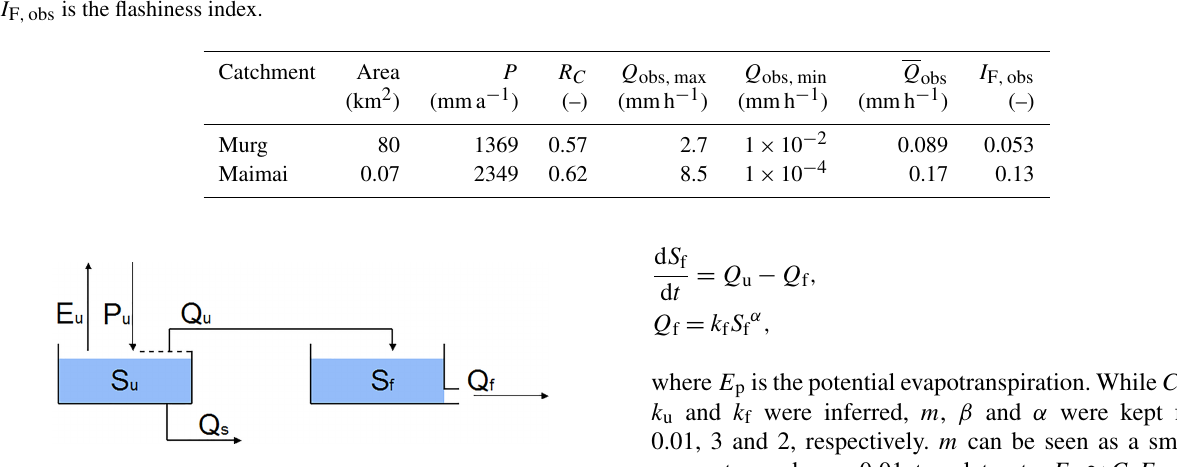
Figure 2. Structure of the deterministic hydrological model used in this study. P u is the precipitation and E u the evapotranspiration. S u represents the active water content of the unsaturated zone, while S f is a non-linear reservoir representing the fast flow